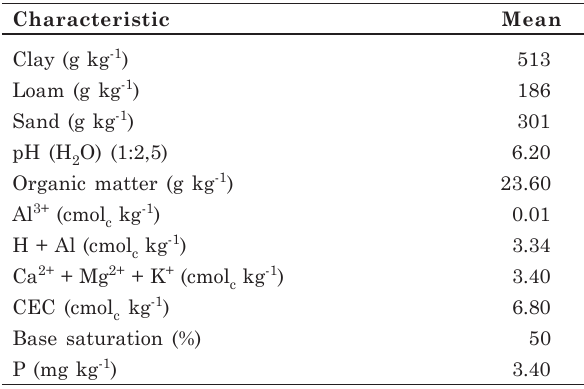
Table 1. Soil physical and chemical characteristics for the 0-20 cm depth of a Typical Acrustox in the Cerrado region of Brazil (mean for n = 20